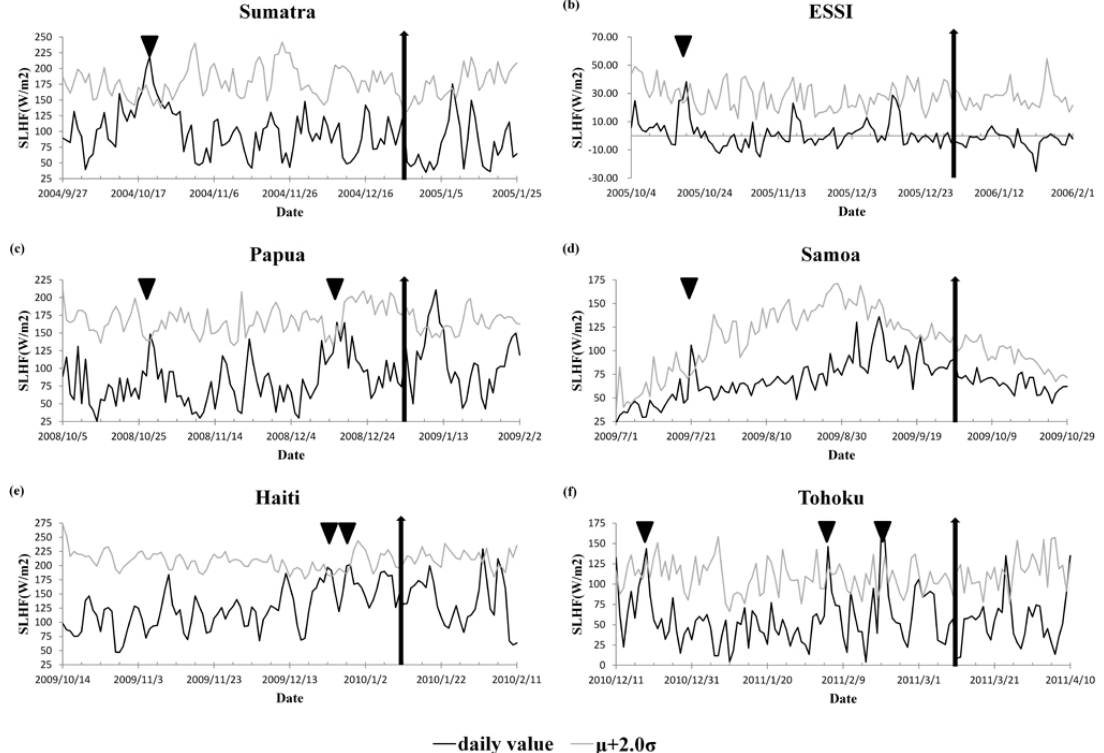
Fig. 3. SLHF variations for the six